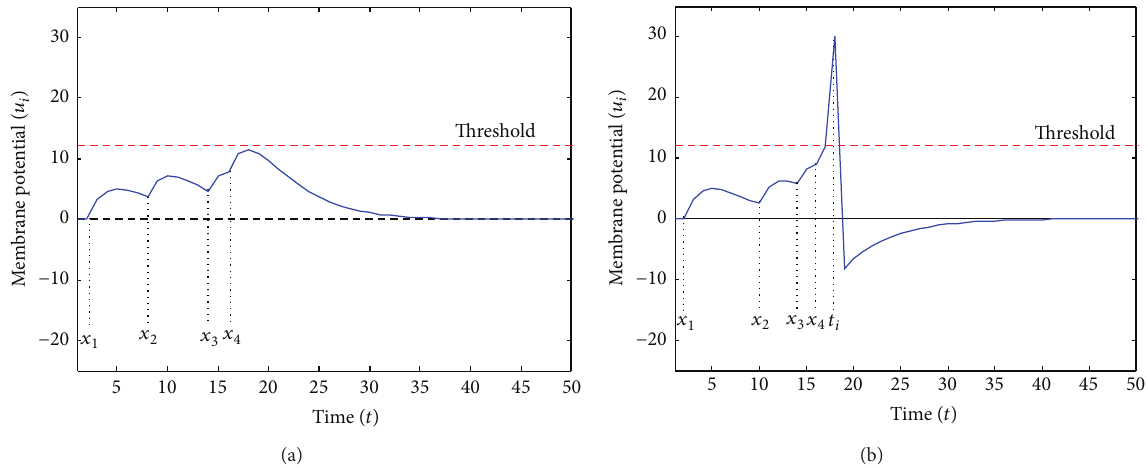
(𝑥 , 𝑥 ,𝑥 ,𝑥 ) = 0, and (b) the output is 4 1 2 3 4